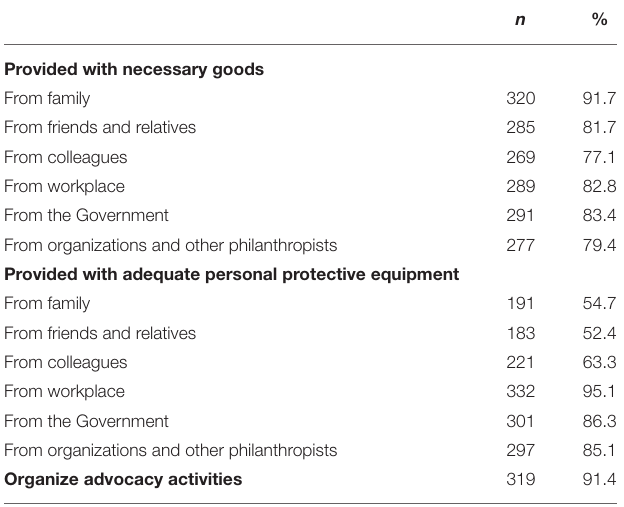
TABLE 3 | Perception of the support provided during the COVID-19 pandemic.